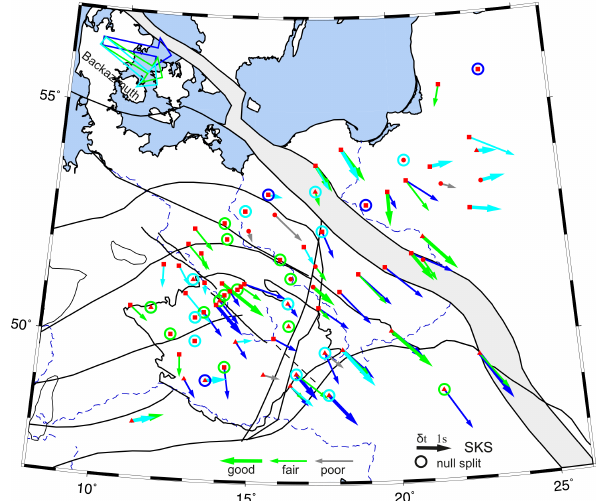
Figure 9. PMs for three events from the NE (the same as in Fig. 8). To emphasize variations of the PM across and along the TESZ, three profiles of the BB stations are marked by coloured bands, whose widths are in relation to the width of the PM ellipses: orange – three areas of broad PMs (in the BM, TESZ/TTZ and EEC) along profile I; red – broad PMs in the BM, followed by narrow PMs, getting gradually broader in the EEC along profile II; yellow – mostly linear PMs along profile III.